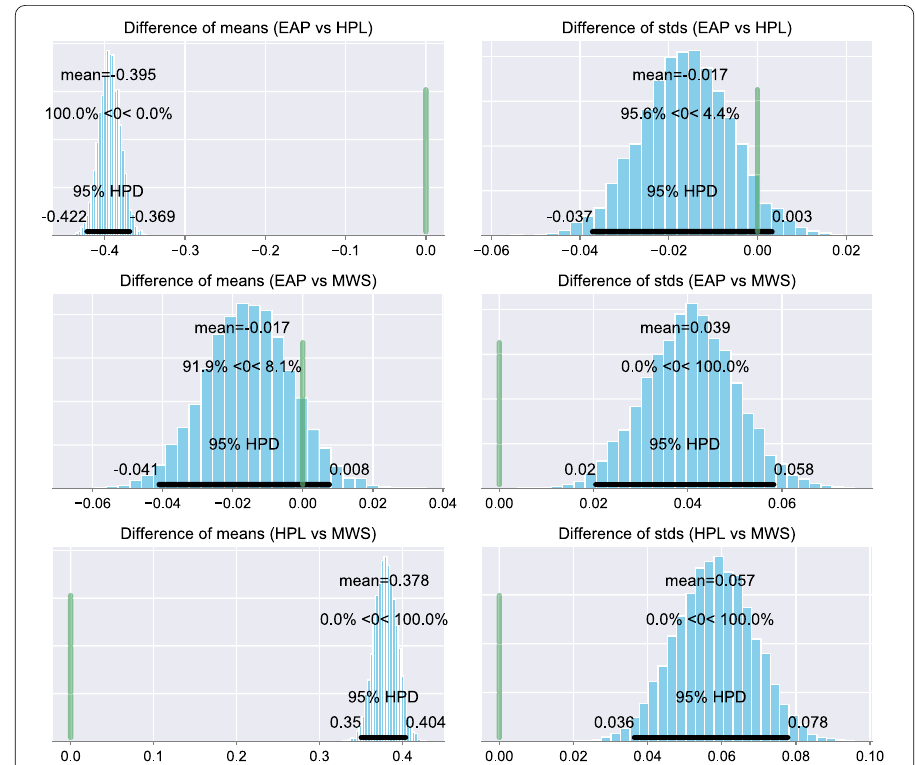
Figure 16 Posterior distributions and 95% credible intervals of differences for log-transformed feature Median-Token-Rank . Left column: difference of means. Right column: difference of standard deviations. Top row: EAP vs HPL. Middle row: EAP vs MWS. Lower row: HPL vs MWS. The 95% credible intervals are shown as a black horizontal line